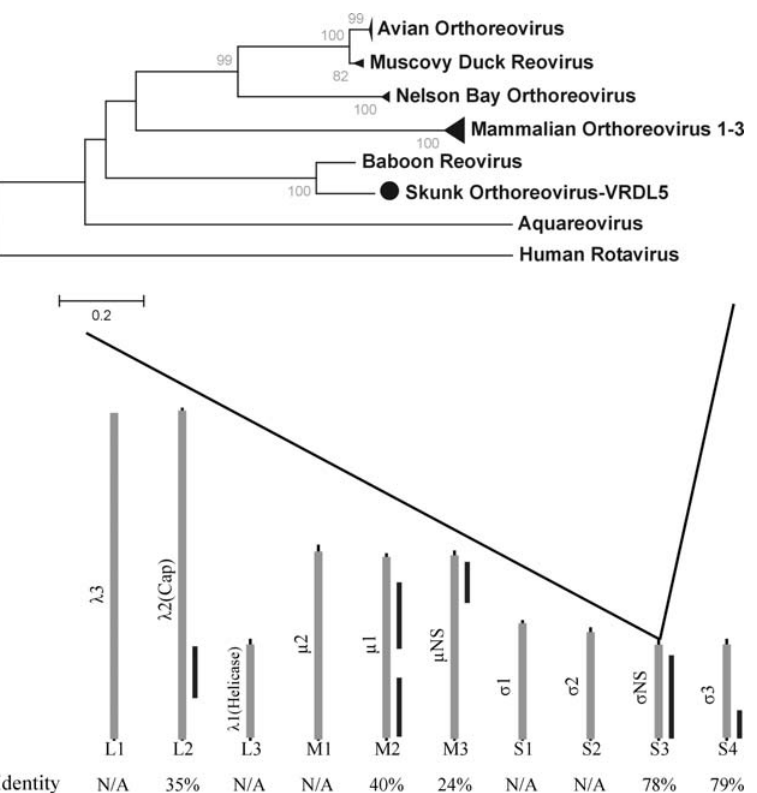
Figure 4. Novel Orthoreovirus. Alignment of six VRDL5 fragments amplified through viral discovery approach to ten genomic fragments of model orthoreovirus with amino acid identities (bottom). Neighbor-joining tree from orthoreovirus sigmaNS protein with bootstrap values from 1000 pseudo-replicates (top).